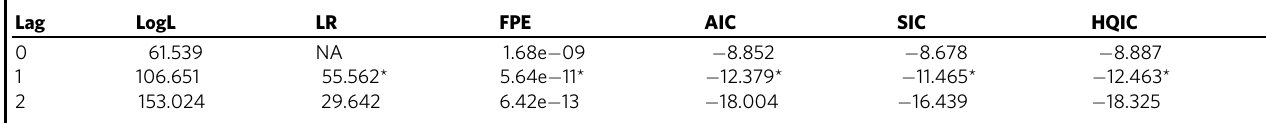
Table 3 SVAR lag order selection